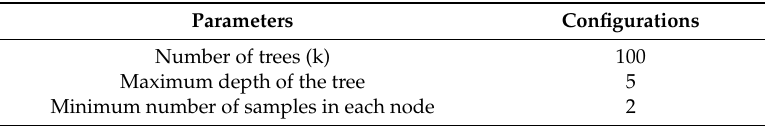
Table 3. Parameterization of random forest classifier.